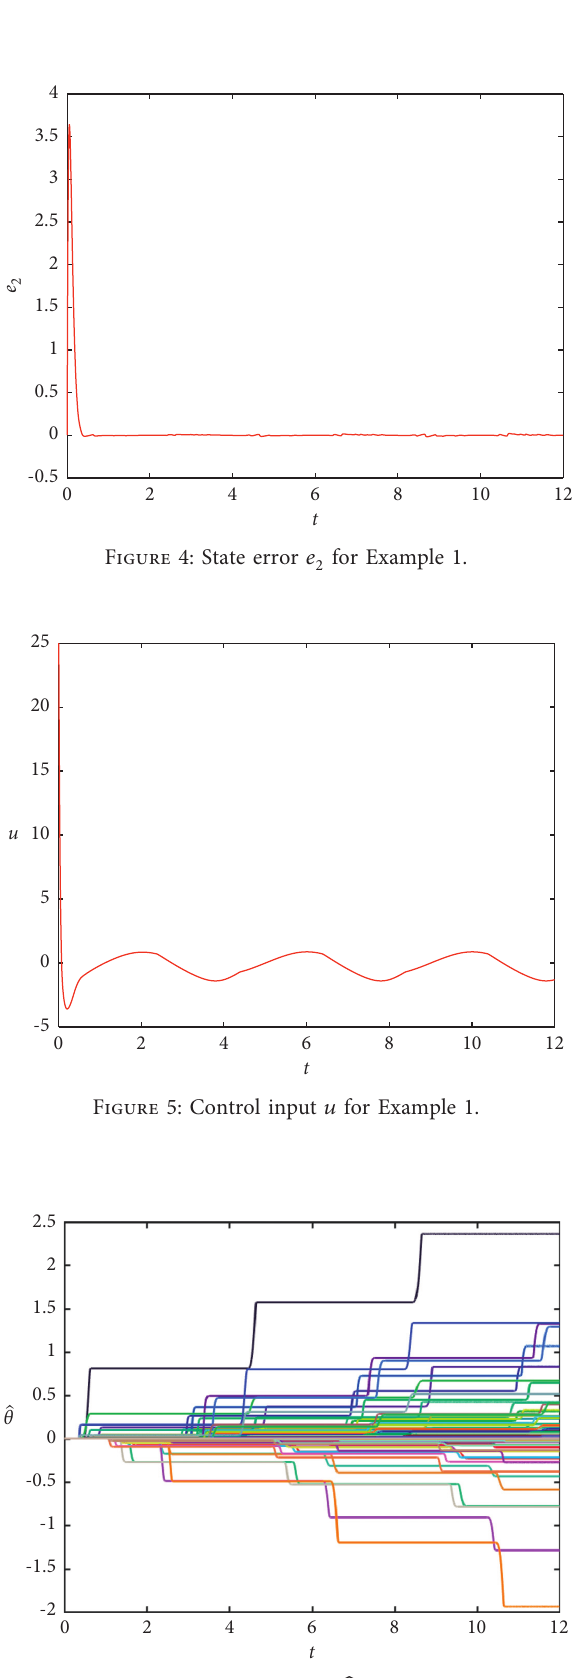
Figure 6: Weights estimates 􏽢 θ for Example